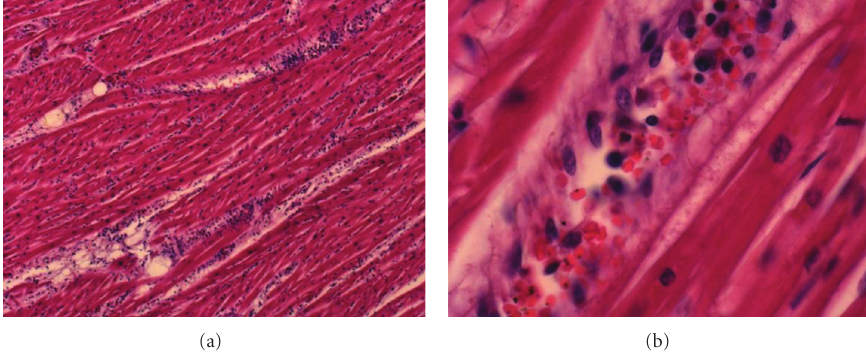
Figure 1: Acute myocarditis due to P. falciparum . (a) Extensive lymphocytic infiltrates surrounding myocardial capillaries and (b) Lymphocytes and parasitized RBCs sequestered in the lumen. Haematoxylin and eosin, × 20 (a) and × 40 (b); original magnification.